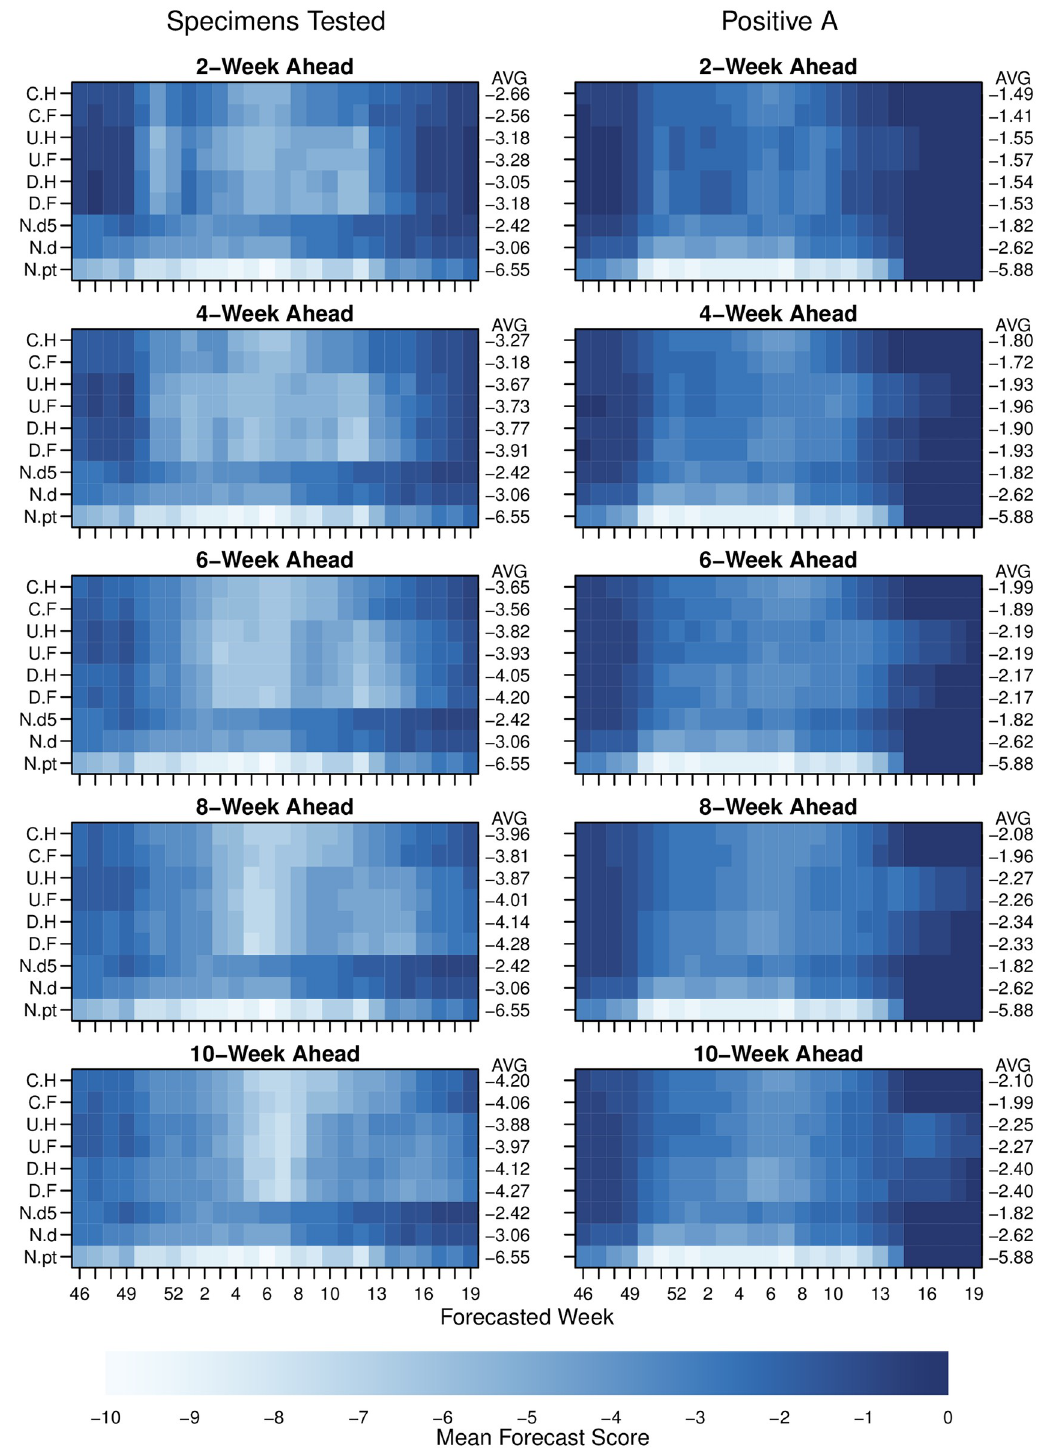
Fig 3. Forecast scores for 2- to 10-weeks ahead lead times, and comparing different data metrics. Pixel colour shows forecast score (see main text) for a given observation week averaged across clusters and seasons, e.g. the 4-week ahead forecast for week 48 was made using data only up to week 44. Averages across all weeks for a given model are printed on the RHS of each row of pixels. Model type is shown on LHS y-axis tick labels: C.H, coupled model with humidity modulated contact rate; C.F, coupled model with fixed contact rate; U.H, uncoupled with humidity; U.F, uncoupled with fixed contact rate; D.H, model directly fitted to cluster with humidity term; D.F, model directly fitted to cluster with fixed contact rate; N.pt, null model made from